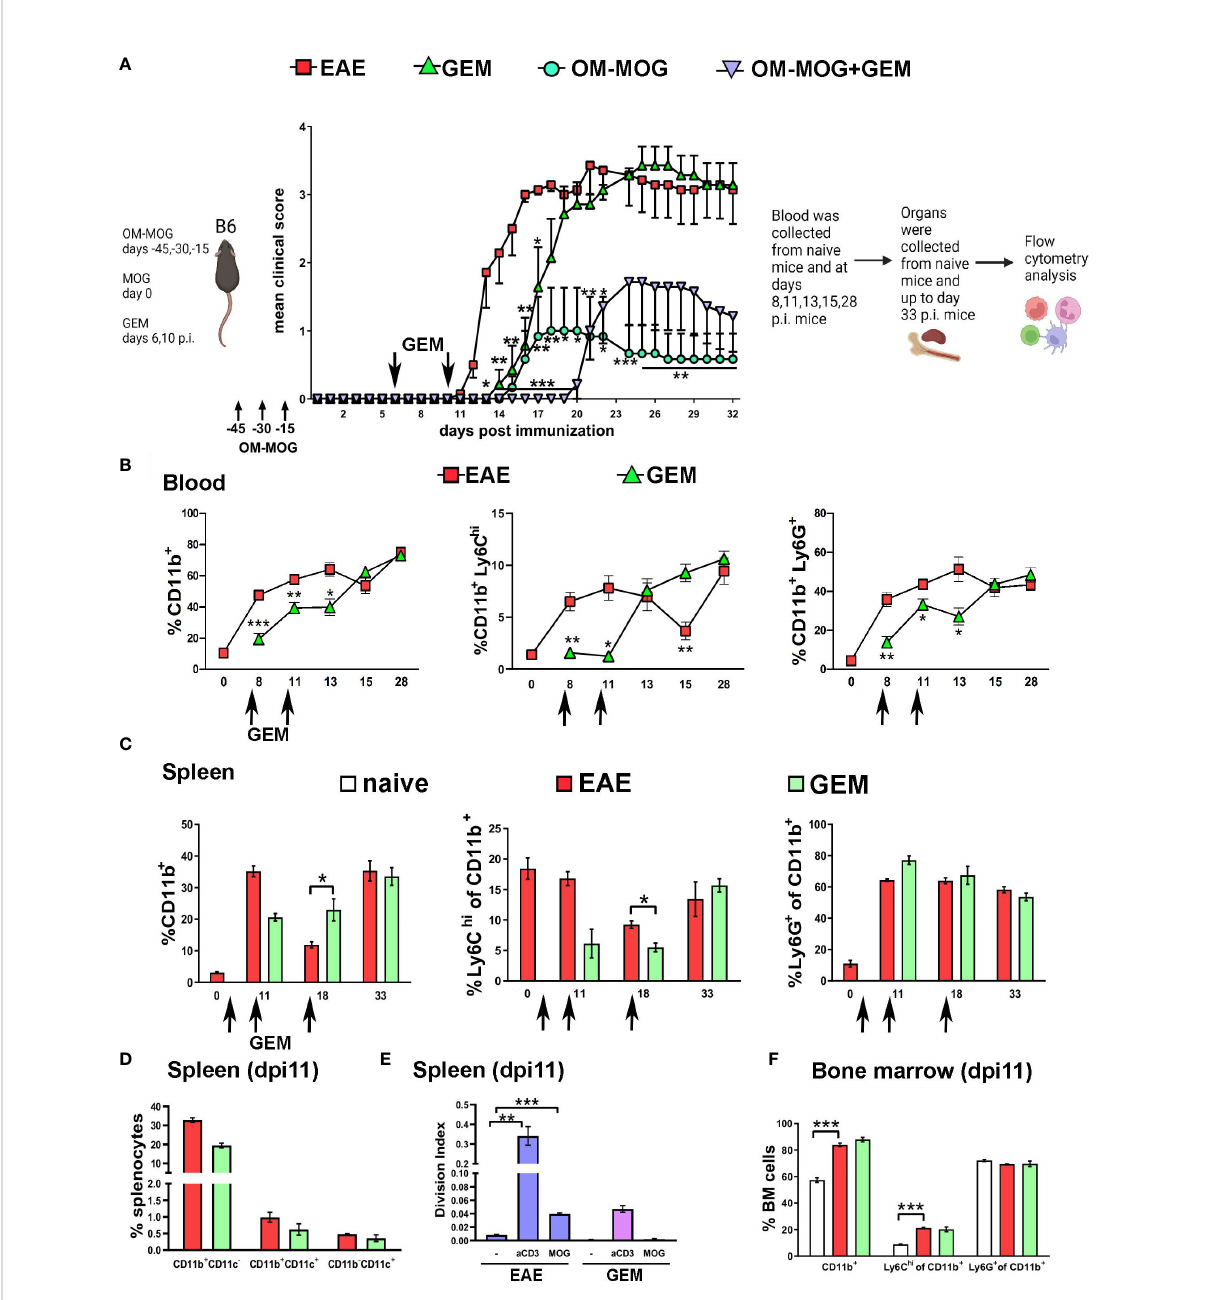
FIGURE 2 Gemcitabine transiently delays EAE onset and extends protection by OM-MOG. (A) Schematic representation of the experimental approach and the time points of injection of OM-MOG and gemcitabine (GEM) in the EAE mice. Mean clinical scores of EAE mice after long-term prophylactic administration of OM-MOG (days -45, -30, -15 relative to immunization for EAE, upward arrows) and pre-onset administration of GEM (dpi 6 and 10, downward arrows) (n=6-7/group). (B) Time-course of CD11b + , Ly6C hi and Ly6G + myeloid cell expansion in blood of EAE mice untreated or treated with GEM (dpi 6 and 10; arrows) (n=2 at day 0 and n=4-5 mice/group/time-point). (C) Time-course of CD11b + , Ly6C hi and Ly6G + myeloid cell expansion in spleens of EAE mice untreated or treated with GEM (dpi 6, 10 and 17; arrows) (n=2-3/group/time-point). (D) Proportions of different populations of myeloid cells, including CD11b + CD11c - , CD11b + CD11c + (myeloid DC) and CD11b - CD11c + DC cells, in spleens of EAE mice untreated or treated with GEM shown in C, at dpi 11 (n=2-3/group). (E) T cell proliferation responses to MOG or anti- mouse CD3e in spleens of EAE mice untreated or treated with GEM shown in C, at dpi 11 (n=2-3/group). Data are expressed as division index (total number of divisions/cells at start of culture). (F) Proportions of CD11b + , Ly6C hi and Ly6G + myeloid cells in bone marrow of EAE mice untreated or treated with GEM shown in C, at dpi 11, and naïve mice (n=2-3/group). Data and statistical analysis are derived from one experiment in each case (one for A , one for B – F ). Statistical signi fi cance is shown after comparisons to the vehicle (EAE) group using Mann- Whitney test (A) , or pairwise comparisons between groups using Student ’ s t test (B – D, F) or Student ’ s t test followed by Bonferroni post hoc test (E) (*p ≤ 0.05, **p ≤ 0.01, ***p ≤